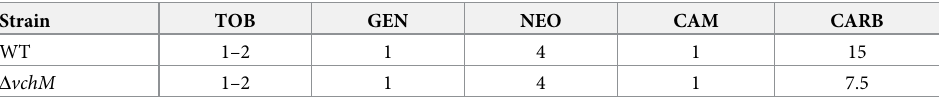
Table 1. MICs ( μ g/ml) of the different antibiotics tested for V . cholerae N16961 WT and Δ vchM strains.